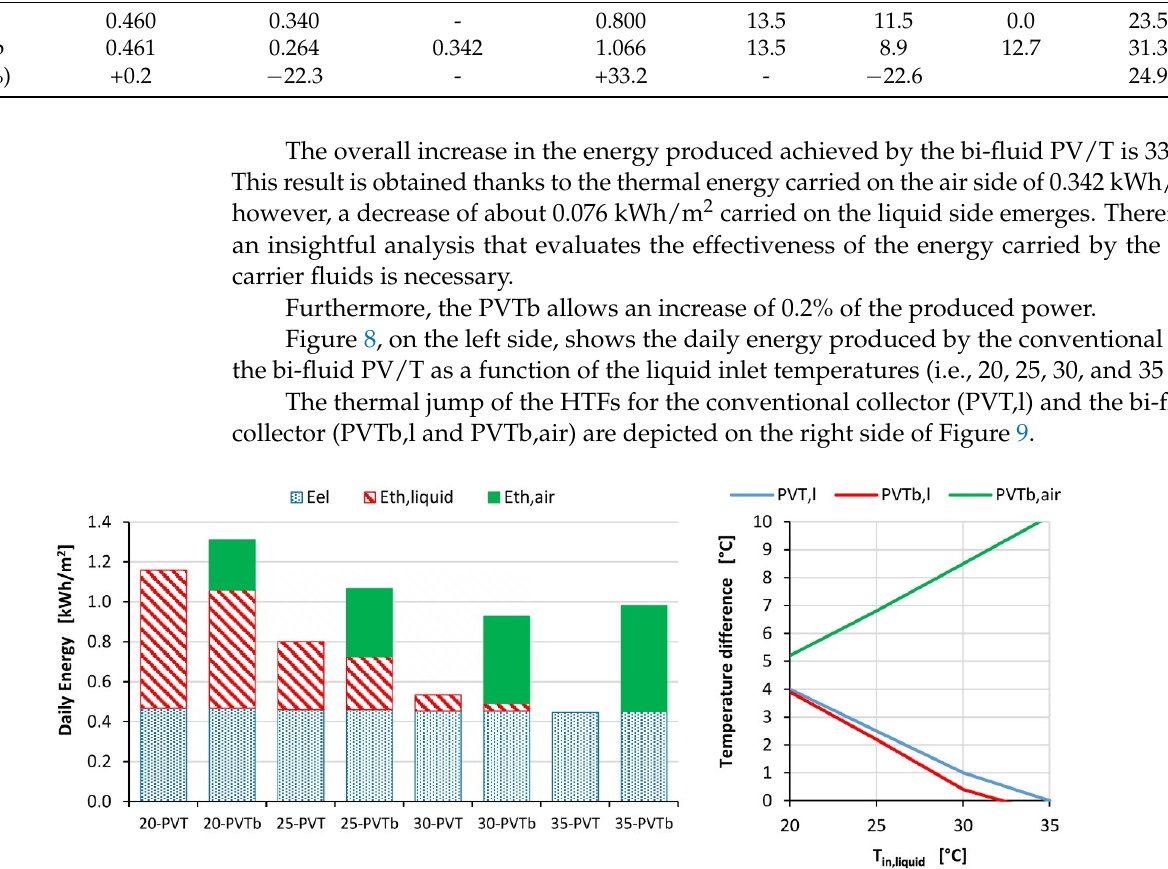
Table 3. Energy yields of the conventional (PV/T) and bi-fluid-collector (PVTb).